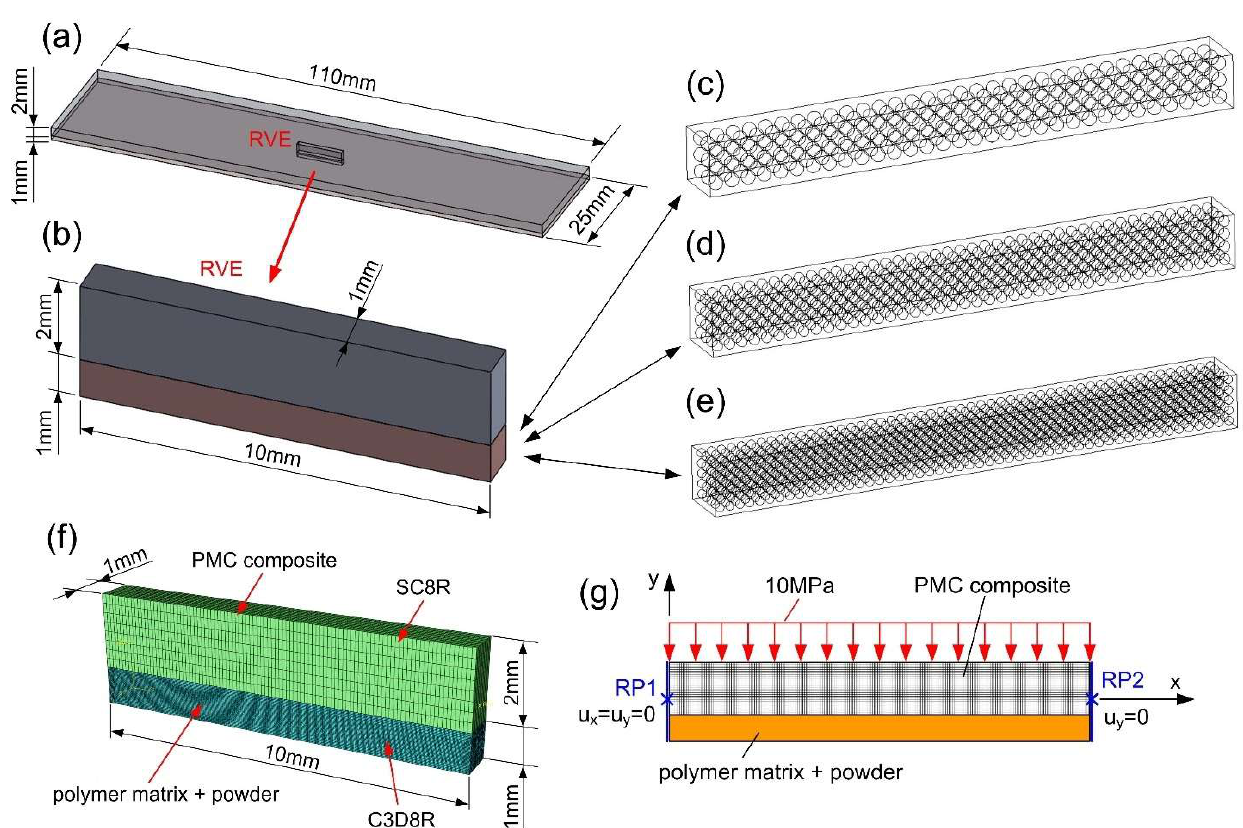
Figure 6. Numerical model: ( a ) global model; ( b ) RVE numerical models, having different numbers and sizes of powder grains, for the analysis of microcrack growth in the PLs; ( c ) model_1: 288 grains; ( d ) model_2: 672 grains; ( e ) model_3: 1300 grains; ( f ) RVE finite element structural mesh of the two-layered composite structure; and ( g ) boundary and loading conditions for numerical analysis of the